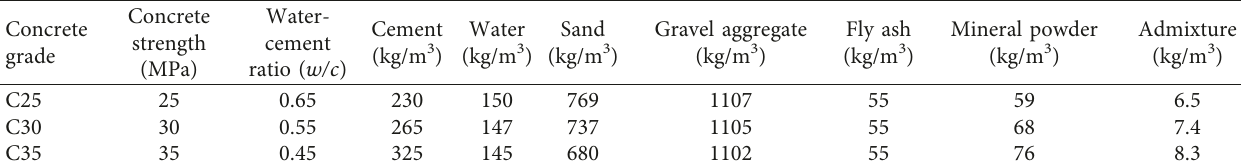
Table 1: Mix composition and properties of